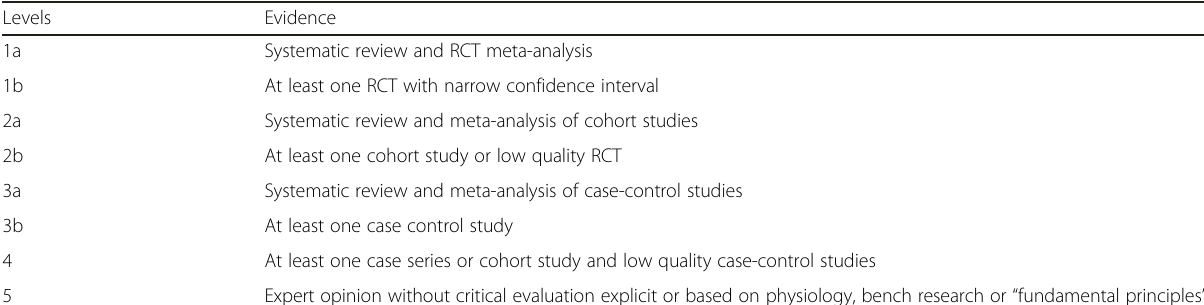
Table 1 Categories of evidence in studies